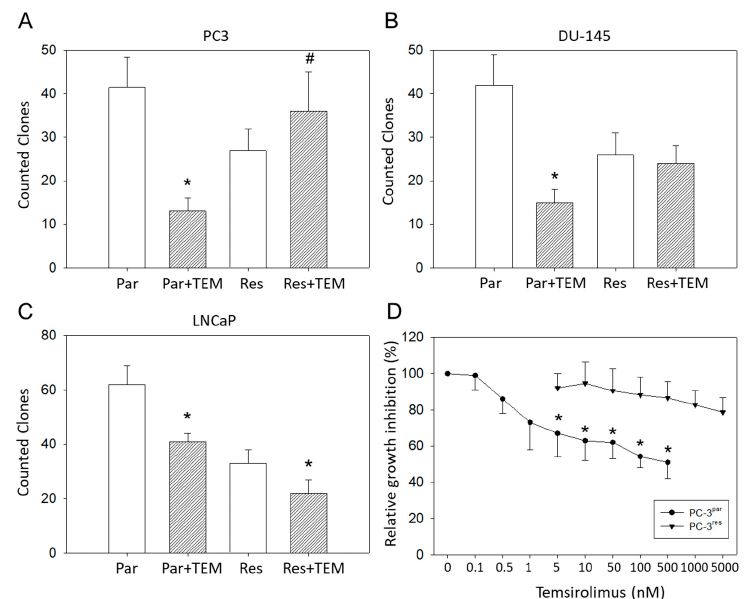
Figure 2. Clonal growth of ( A ) PC3 par versus PC3 res , ( B ) DU145 par versus DU145 res , and ( C ) LNCaP par versus LNCaP res with and without exposure to low-dosed (10 nM) temsirolimus (Par + TEM, Res + TEM). Experiments were done in triplicate and repeated five times. * indicates significant down-regulation following temsirolimus (re)incubation, # indicates significant up-regulation following temsirolimus (re)incubation. ( D ) Dose response of PC3 par and PC3 res cells to 72 h temsirolimus incubation (relative growth inhibition). Controls remained untreated and were set at 100%. * indicates significant difference.